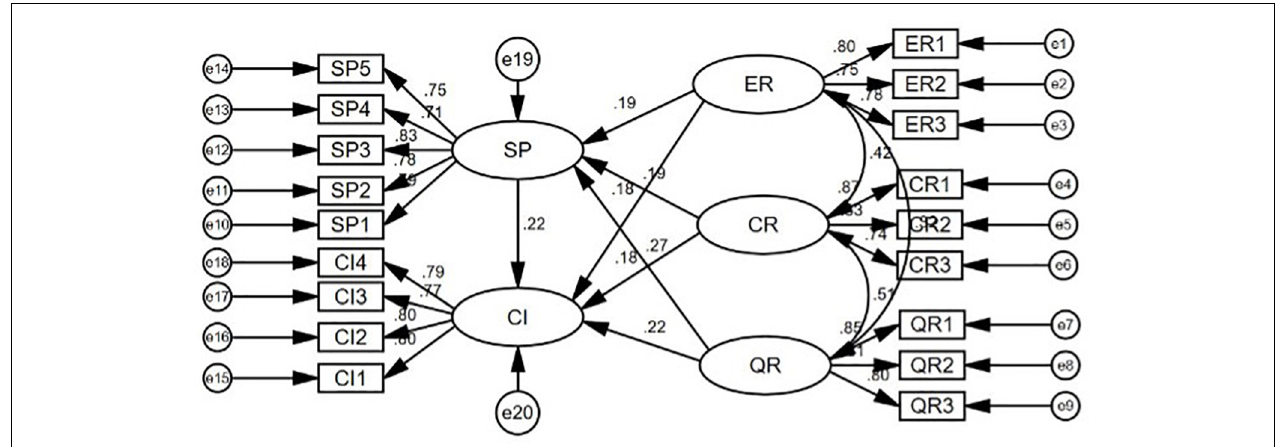
FIGURE 2 | Structural equation model.